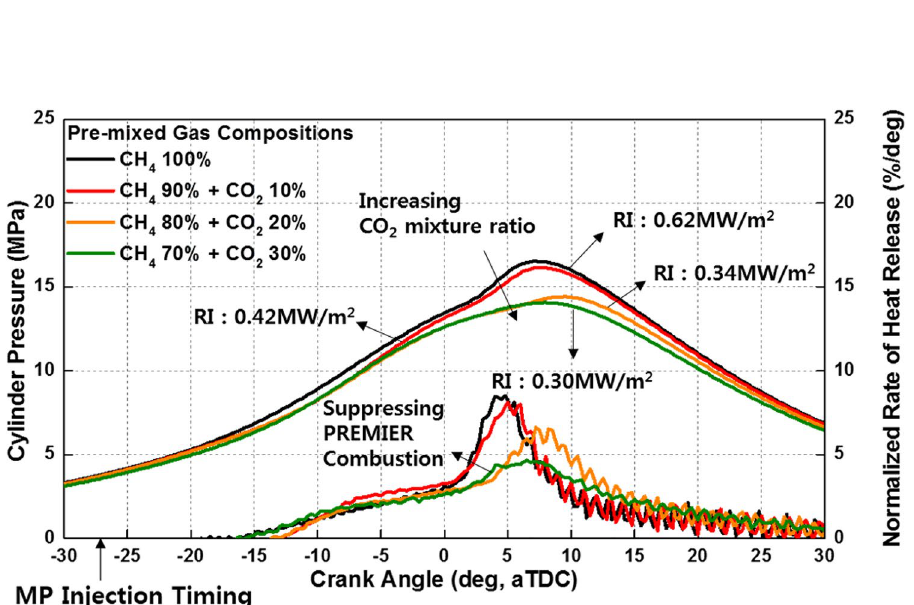
Figure 18. Variation in the cylinder pressure and normalized rate of heat release with the CO 2 mixture